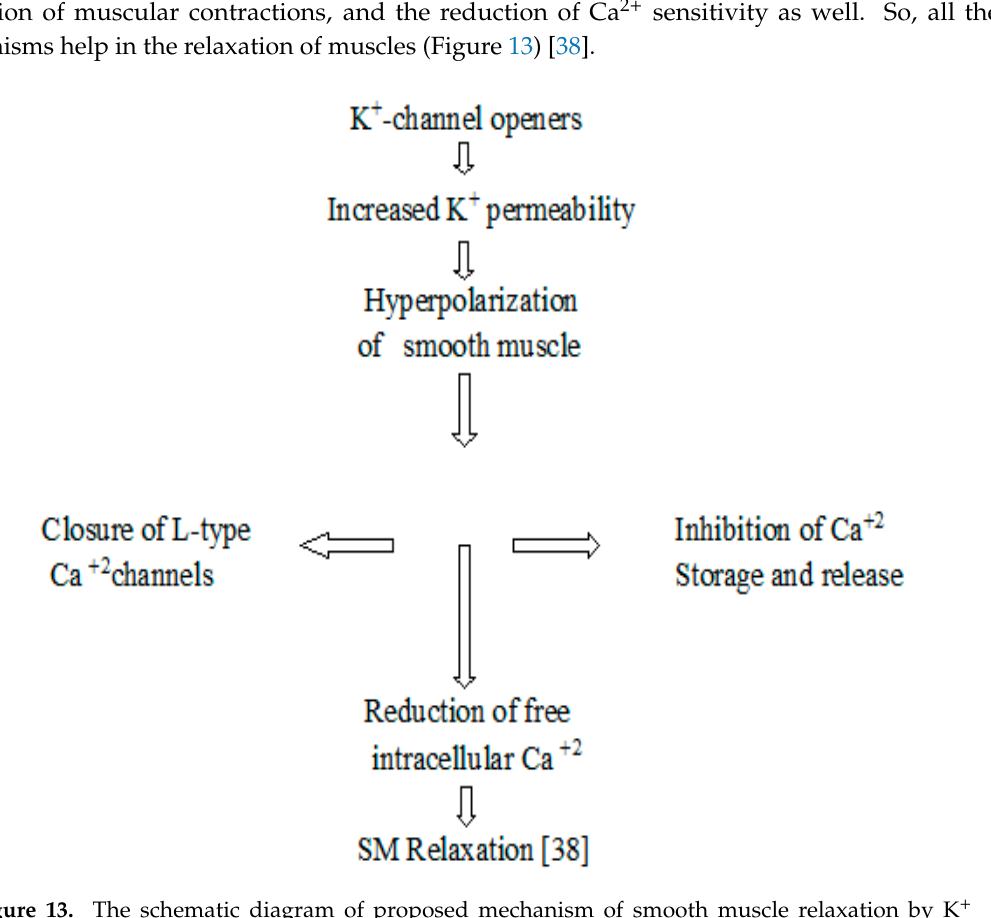
Figure 13. The schematic diagram of proposed mechanism of smooth muscle relaxation by K + channel openers.